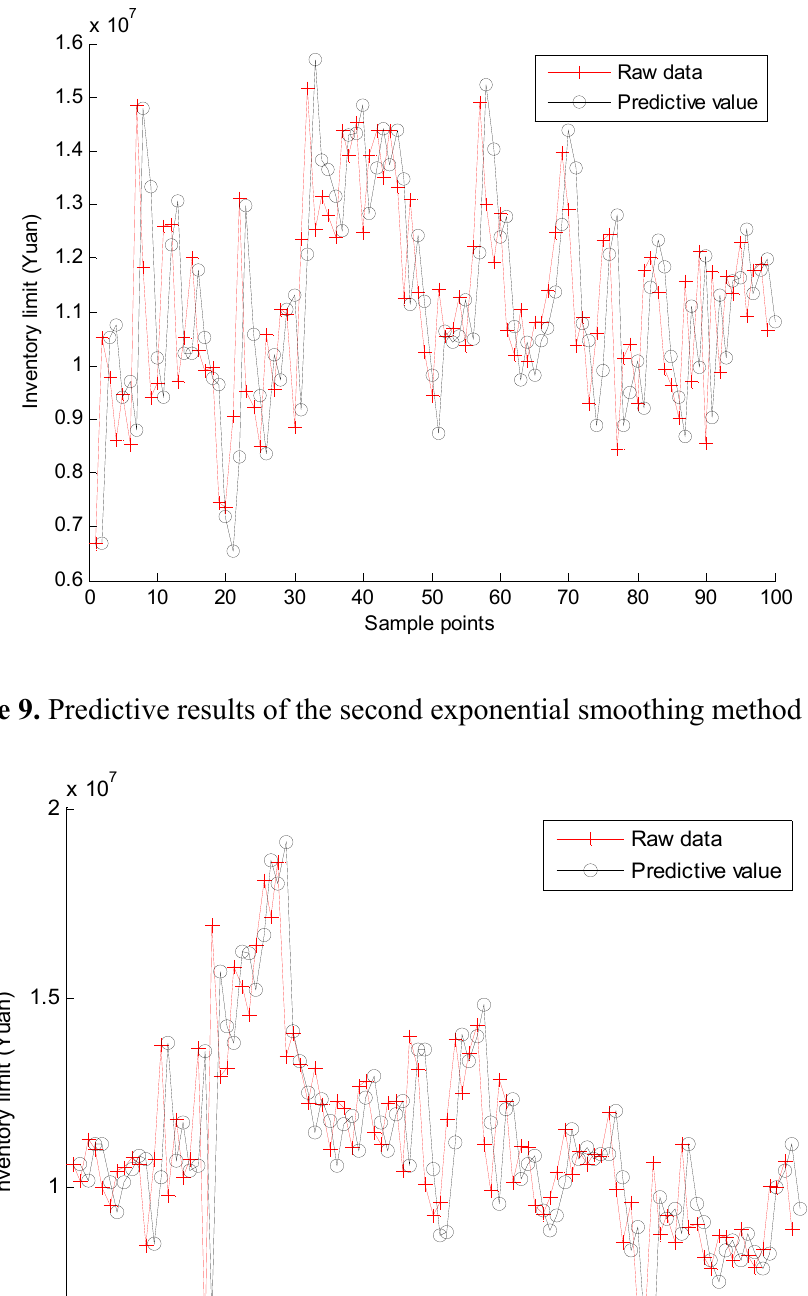
Figure 8. Predictive results of the second exponential smoothing method in 2011.